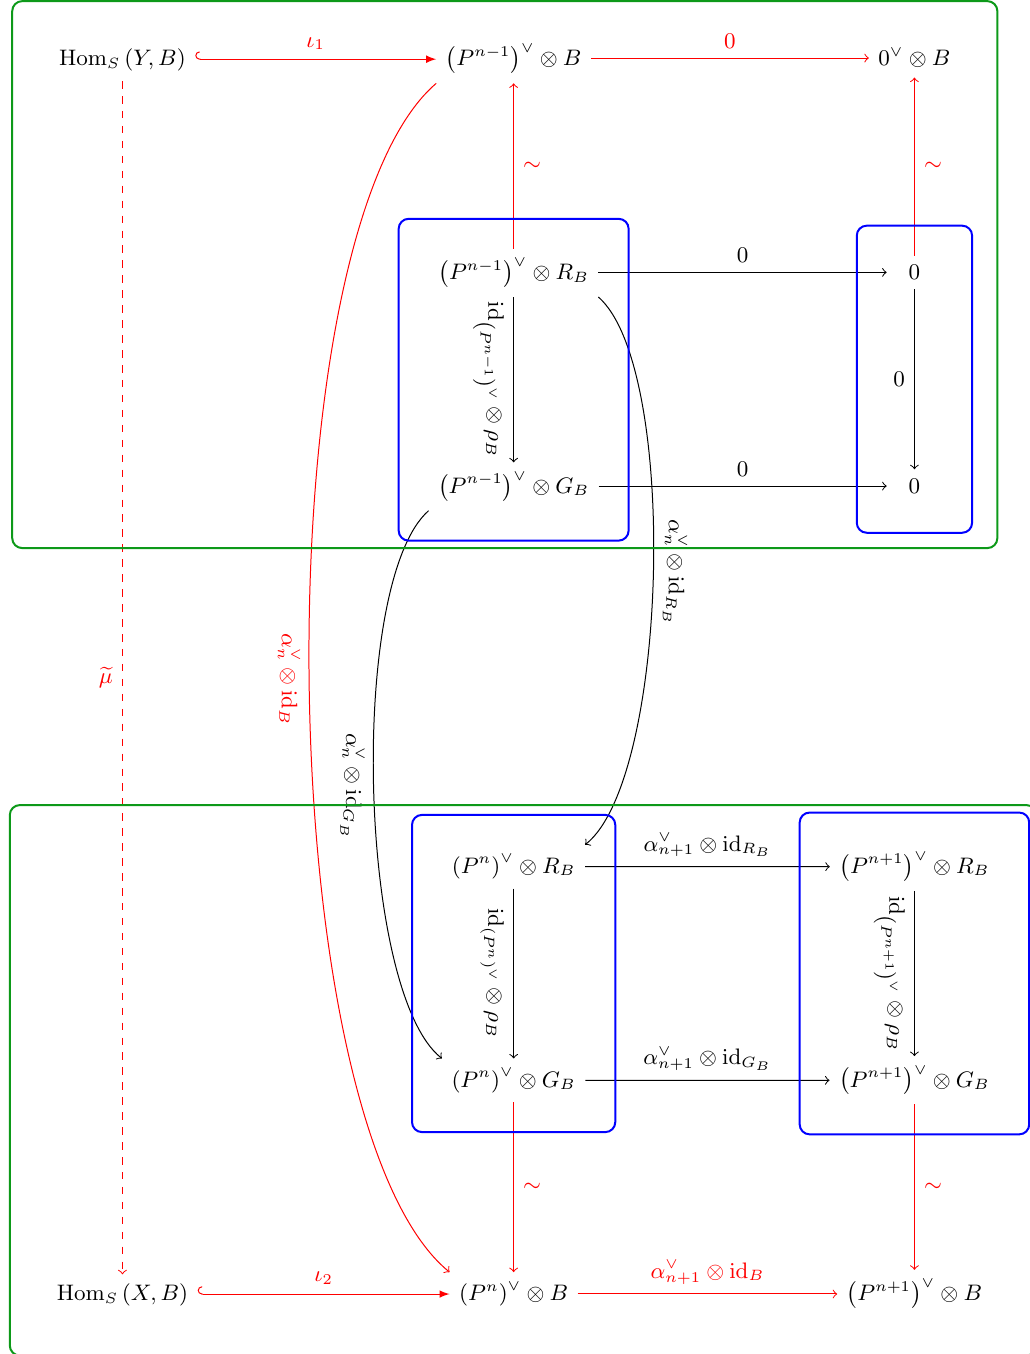
Figure 5. Given (cid:22) : X ! Y we can compute the morphism on the above